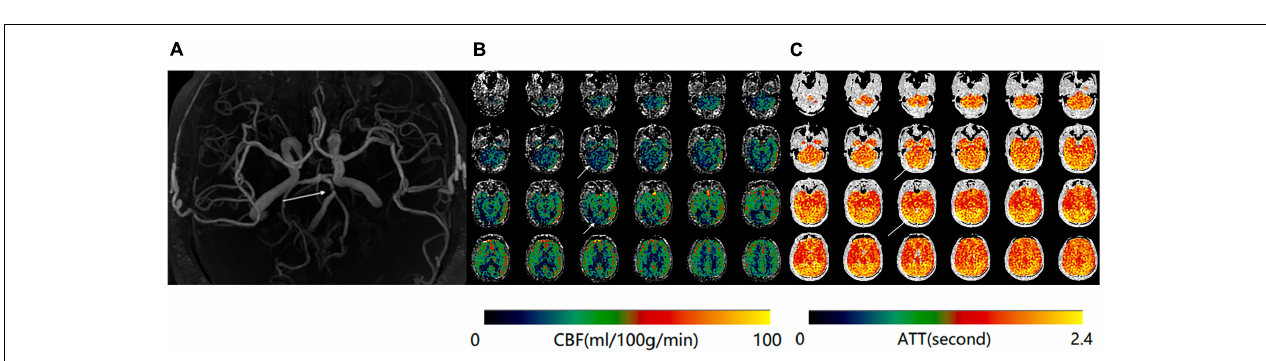
FIGURE 2 | (A) Magnetic resonance angiography (MRA) of a 68-year-old woman shows moderate stenosis of bilateral middle cerebral arteries. (B) Mean cerebral blood flow (mCBF) demonstrates decreased blood perfusion in bilateral temporal and parietal lobes. (C) Prolongation of arterial transit time (ATT) is demonstrated at the same anatomical regions on the ATT map.